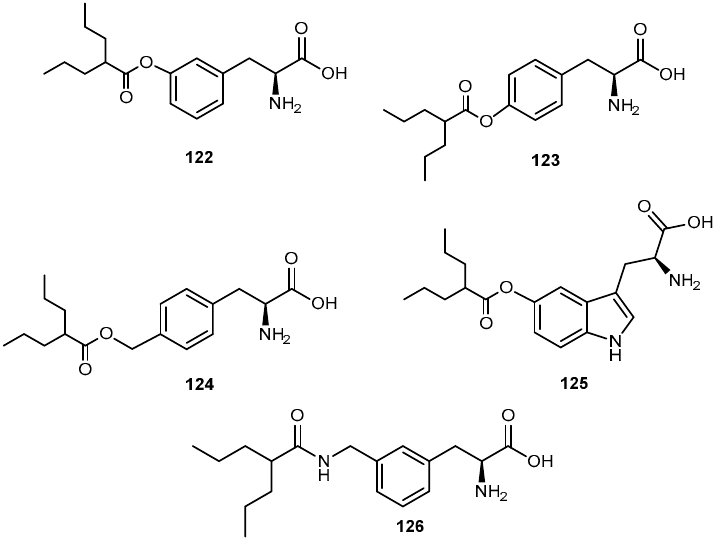
Figure 49. Chemical structures of amino acid esters ( 122 – 125 ) and amide prodrug ( 126 ) of 119 studied by Gynther et al. [161].